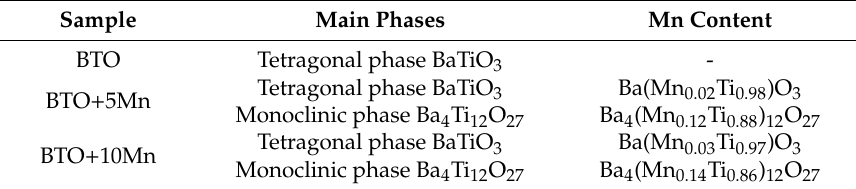
Table 1. Phases in the investigated samples.